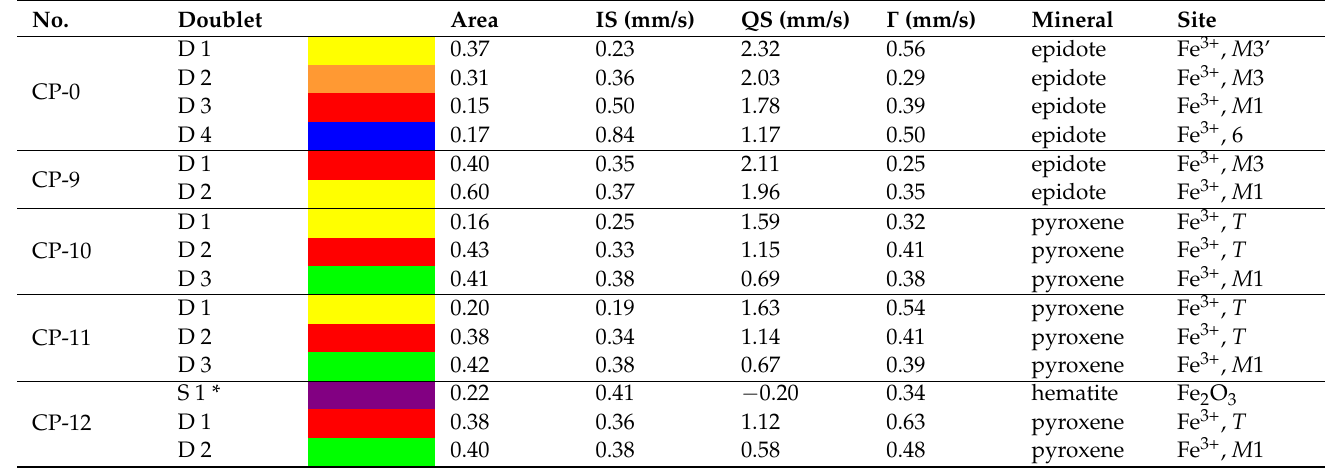
Table 10. Parameters of 57 Mössbauer spectra for clinozoisite samples. Color of dublets is for their identification in the Figure 8.